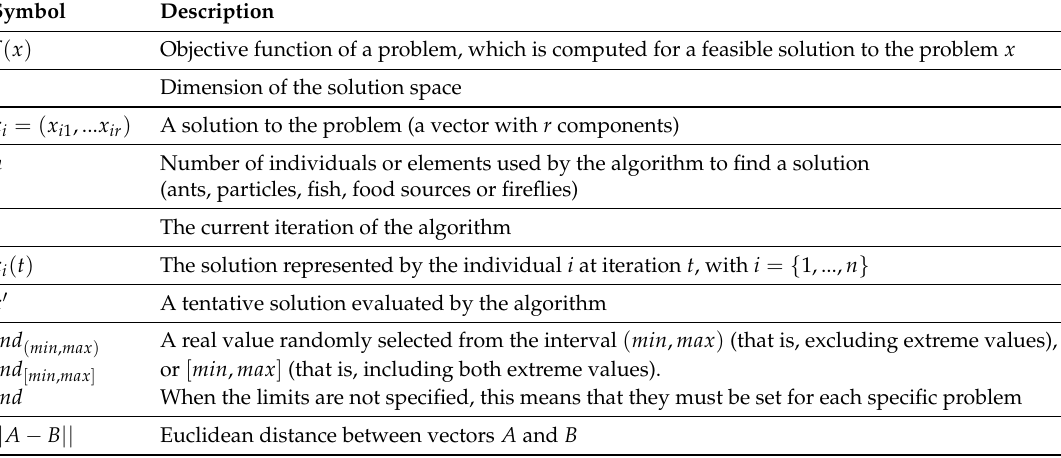
Table 1. Notation used to describe the